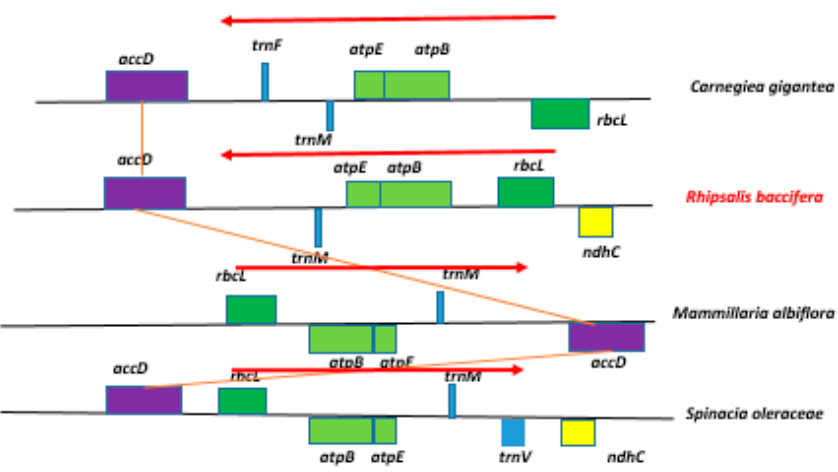
Figure 2. Structural organization of a portion of the LSC region showing location of the ~6kb inversion in the cp genome of R. baccifera and other species of suborder Portulacinae relative to Spinacia oleraceae cp genome . Talinum paniculatum and Portulaca oleraceae have similar arrangement of these genes as in S. oleraceae .